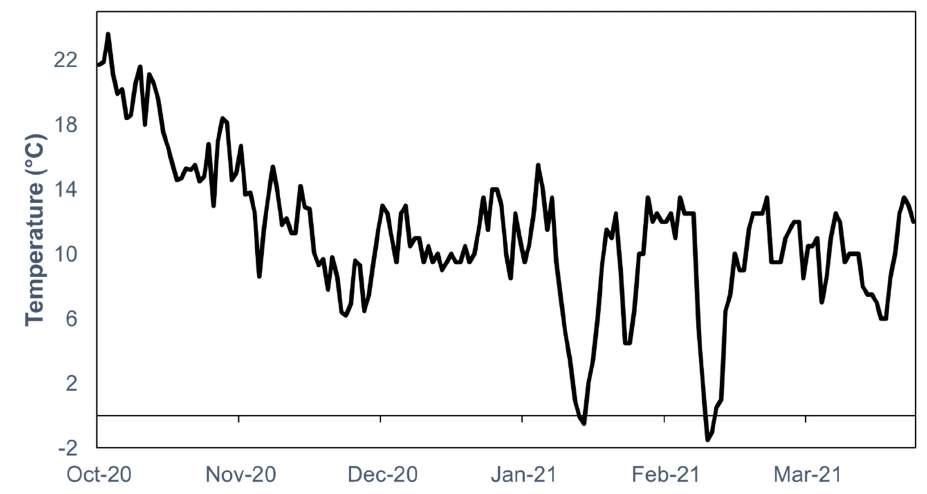
Figure 2. Average daily temperature ( ◦ C) in Thermi, Thessaloniki, Greece during the months of October, November, December 2020, and January, February and March 2021. Data recorded with HOBO U23 Pro v2 Temperature/Relative Humidity Data Logger (Onset Computing, Bourne, MA, USA).